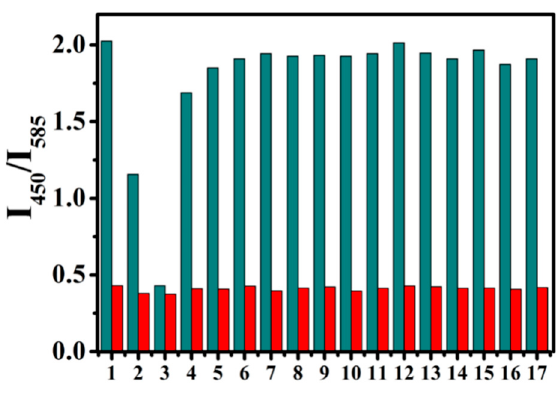
Figure 6. Fluorescence response of dual-emission microspheres (excited at 360 nm) to various metal ions and several common anions (20 μ M, green bars) and the subsequent addition of Hg 2+ (20 μ M, red bars); 1 is a blank control, and 2 to 17 are Fe 3+ , Hg 2+ , Cu 2+ , Co 3+ , Al 3+ , Ca 2+ , Ni 2+ , Zn 2+ , Br − , I − , Na + , K + , CO 32 − , Mg 2+ , Ba 2+ , and Ag + , respectively.